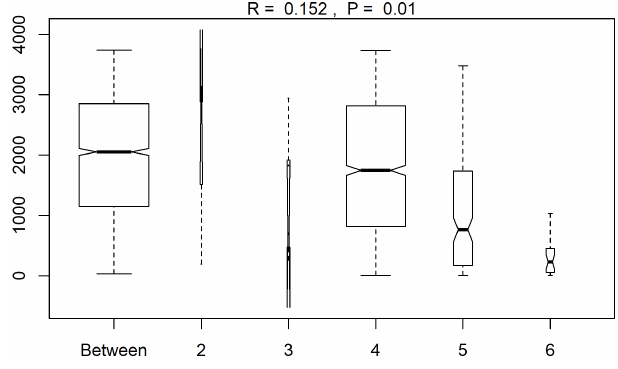
Figure A1. A summary plot from the anosim analysis (testing dif- ferences between the sampling areas in species abundances after the NMDS analysis). Range of dissimilarities in the different areas (2– 6: station 53, station 54, Astrid Ridge, the 6 ◦ E transect and Maud Rise,